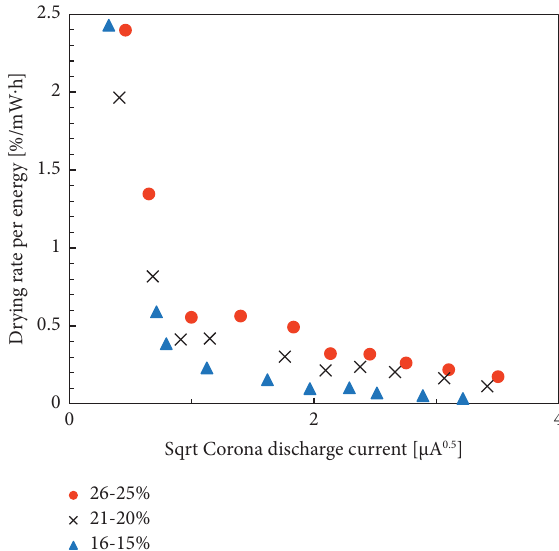
Figure 3: Plot of the drying rate per unit power against the qrt of corona discharge current in each moisture content